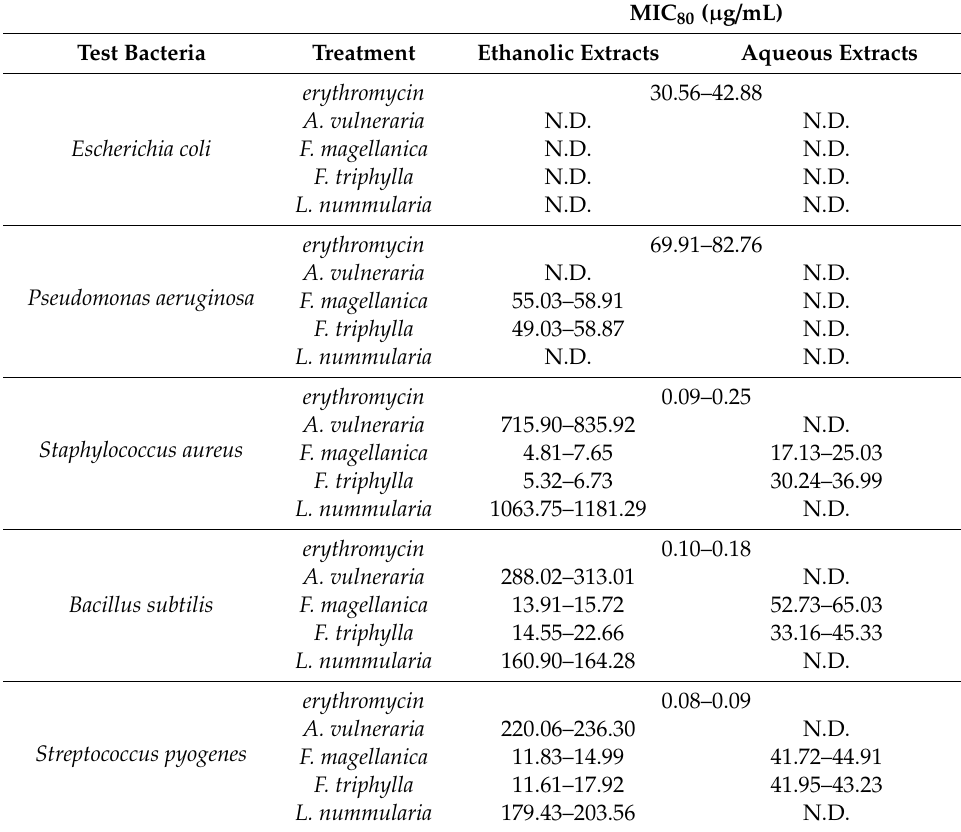
Table 3. Minimum inhibitory concentration (MIC 80 ) of selected medicinal plant extracts on E. coli , P. aeruginosa , S. aureus , B. subtilis and S. pyogenes